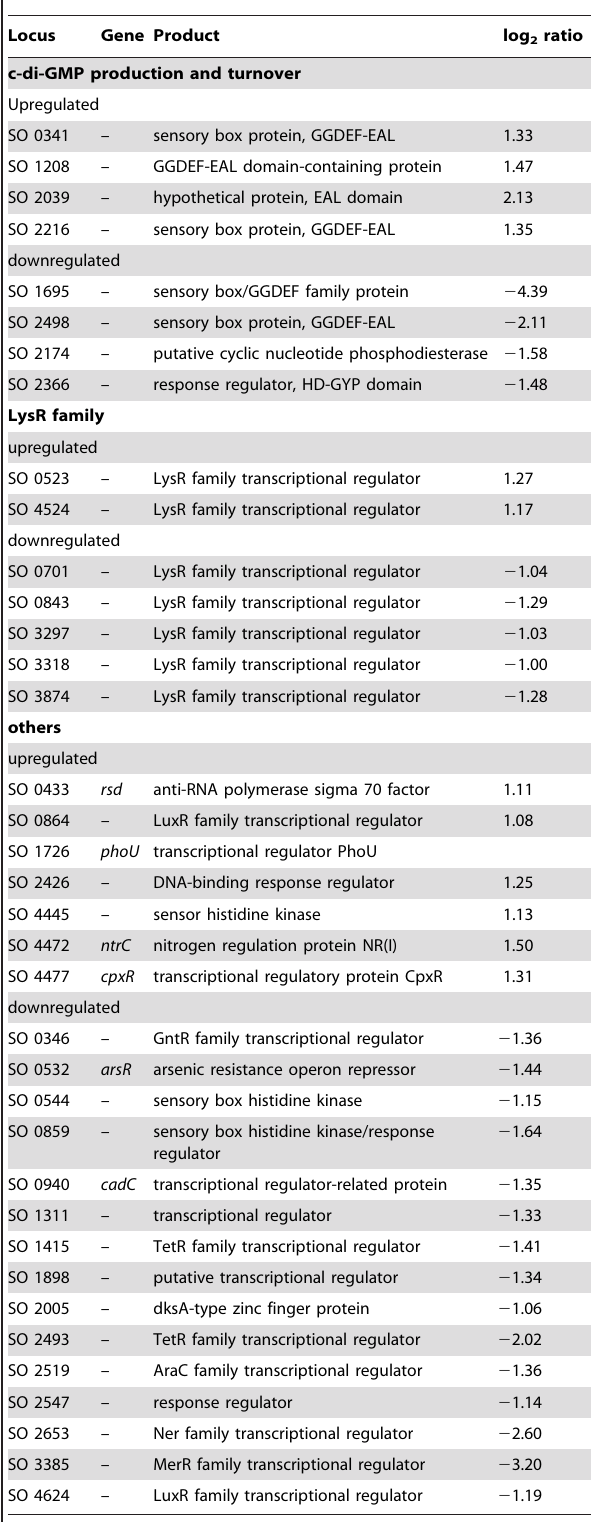
Table 3. Differentially regulated genes related to